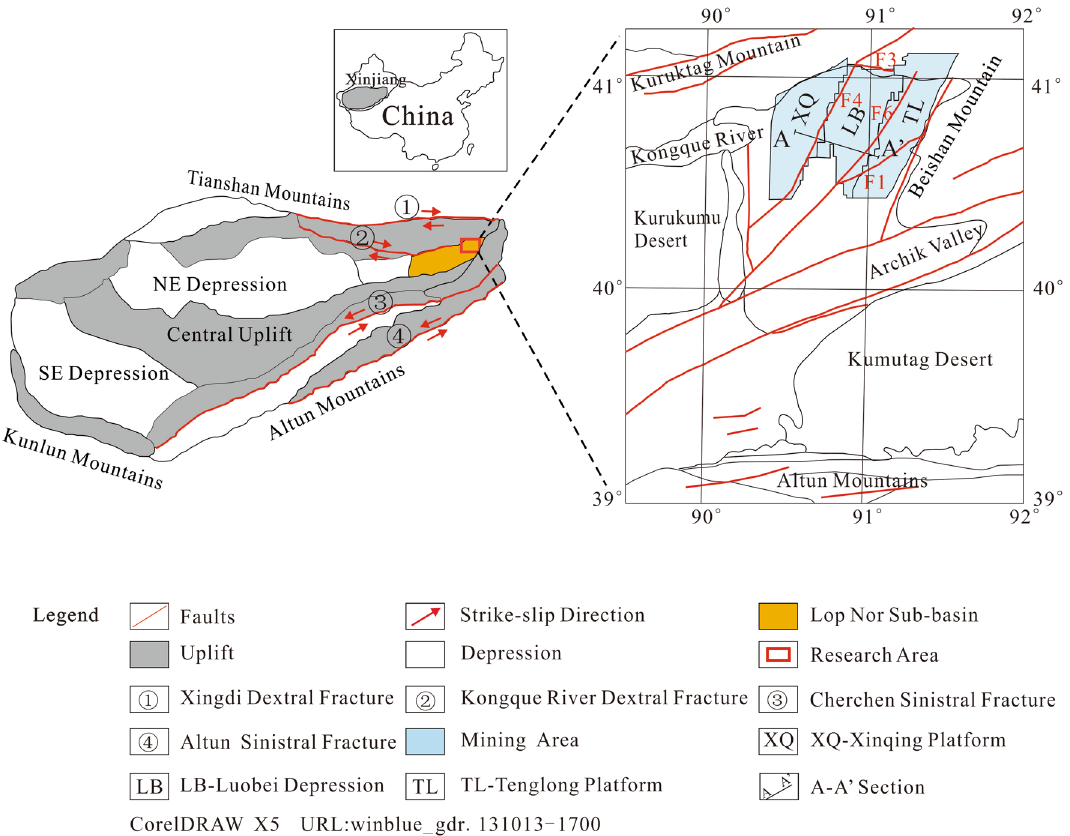
Figure 1. Simplified geological map of the Lop Nor area in Xinjiang Province,